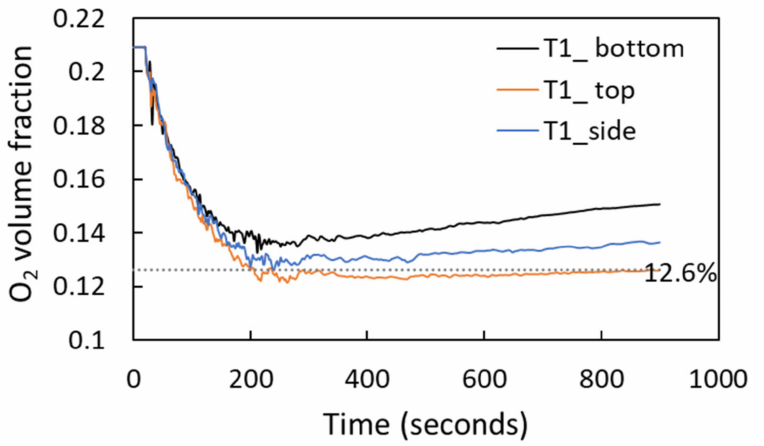
Figure 6. Average oxygen volume fraction within the apartment for the simulation series